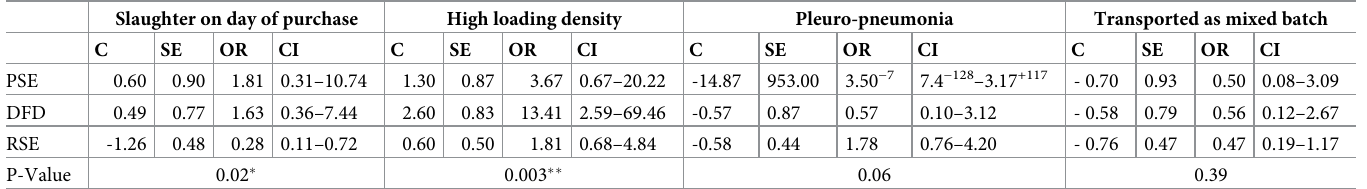
C Coefficients, SE Standard errors, OR Odds ratios, C.I Odds Ratio Confidence Intervals Order followed for all variables. � Represents significant